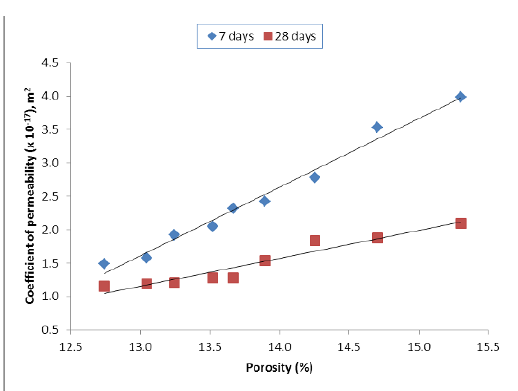
Figure 11. Porosity of OPC and RHA at various grinding time.